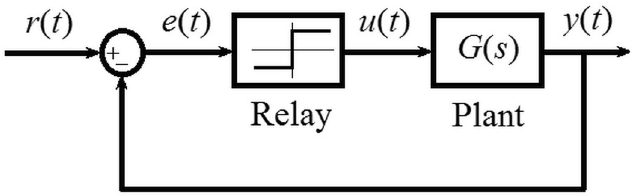
Figure 1. A framework scheme of the relay feedback identification